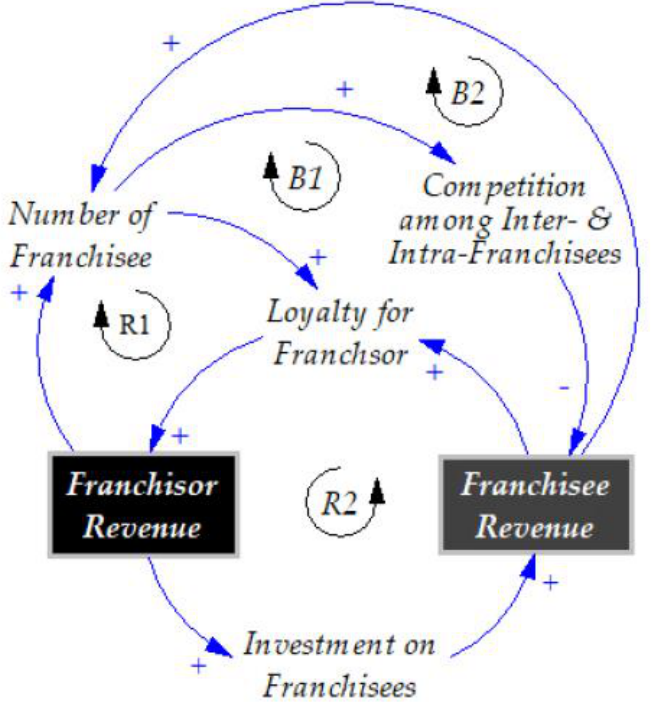
Figure 1. A causal loop diagram of the relationship between franchisors and franchisees.